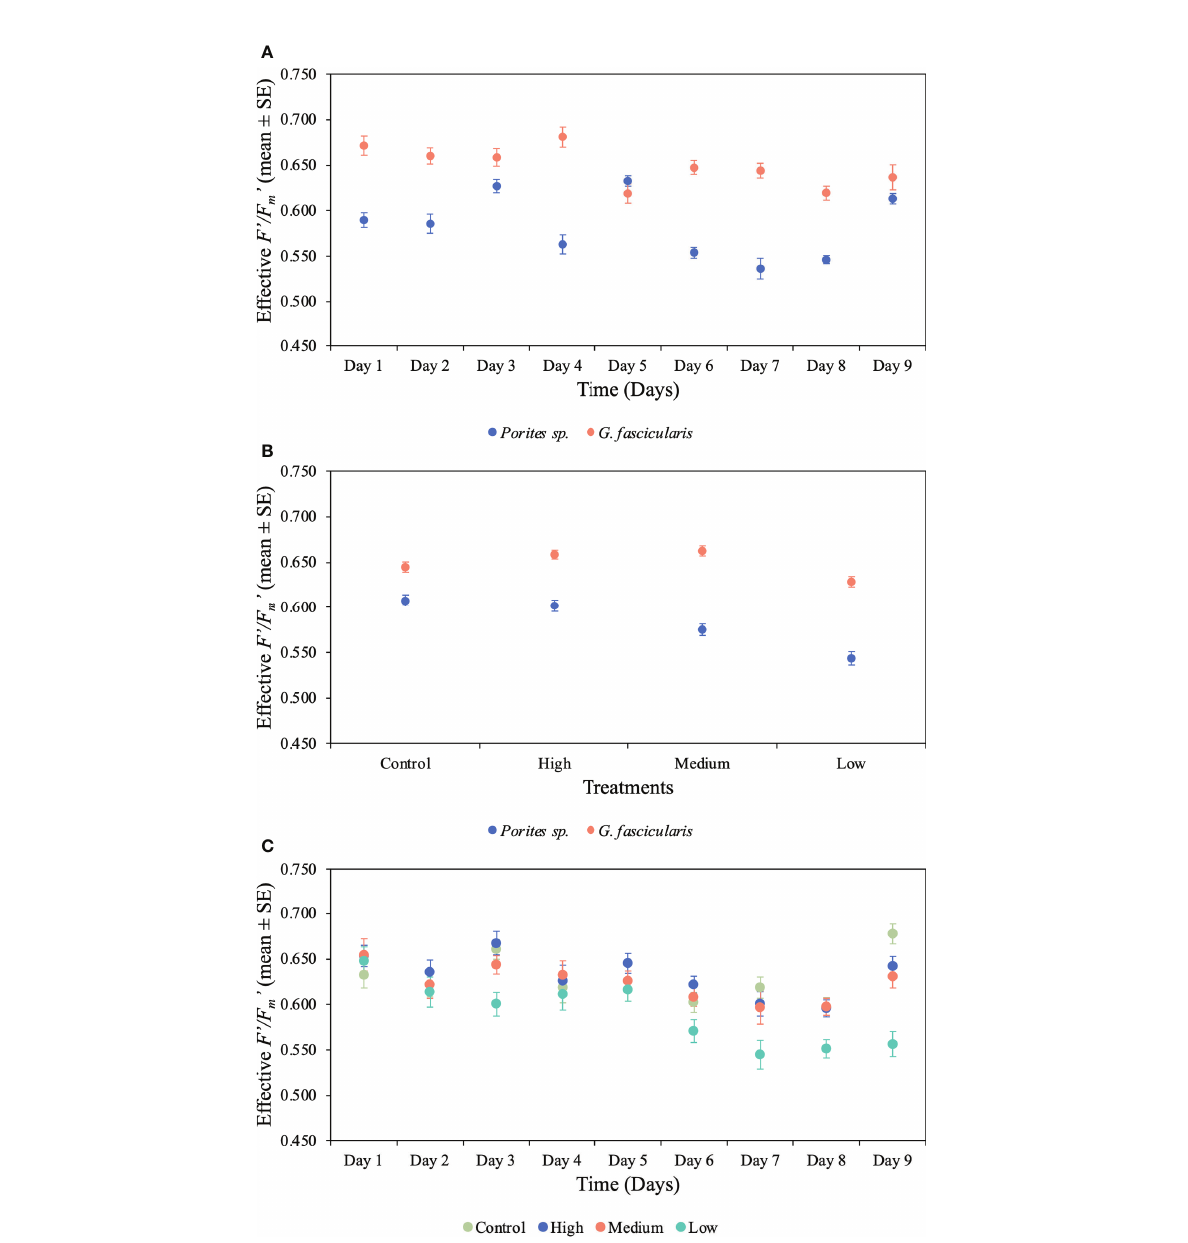
FIGURE 5 Mean (± 1SE) rates of effective photochemical ef fi ciency ( F ′ / F m ′ ) and its interaction between (A) species and time for Porites sp. and G. fascicularis throughout the 10 days of the experiment ( p < 0.001), (B) species and O different O 2 treatments ( p = 0.023), and (C) time and O 2 treatment for Porites sp. and G fascicularis throughout the 10 days of the experiment ( p =